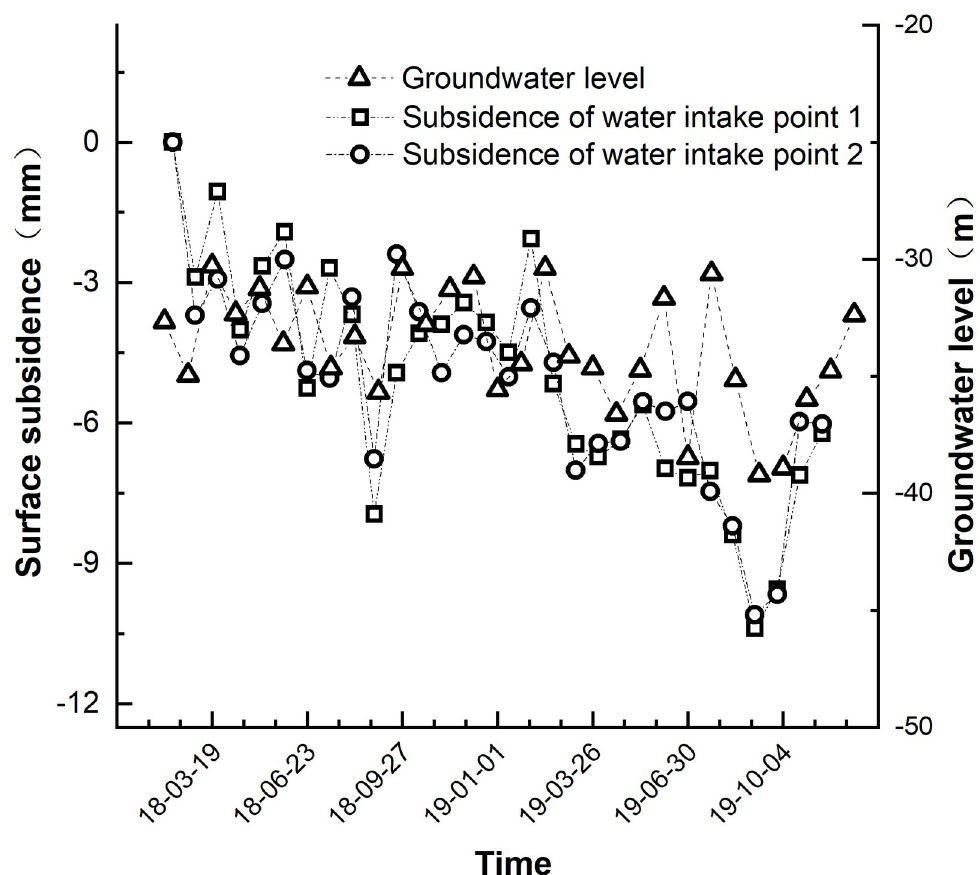
Fig 10. Water level at sampling point vs. ground water